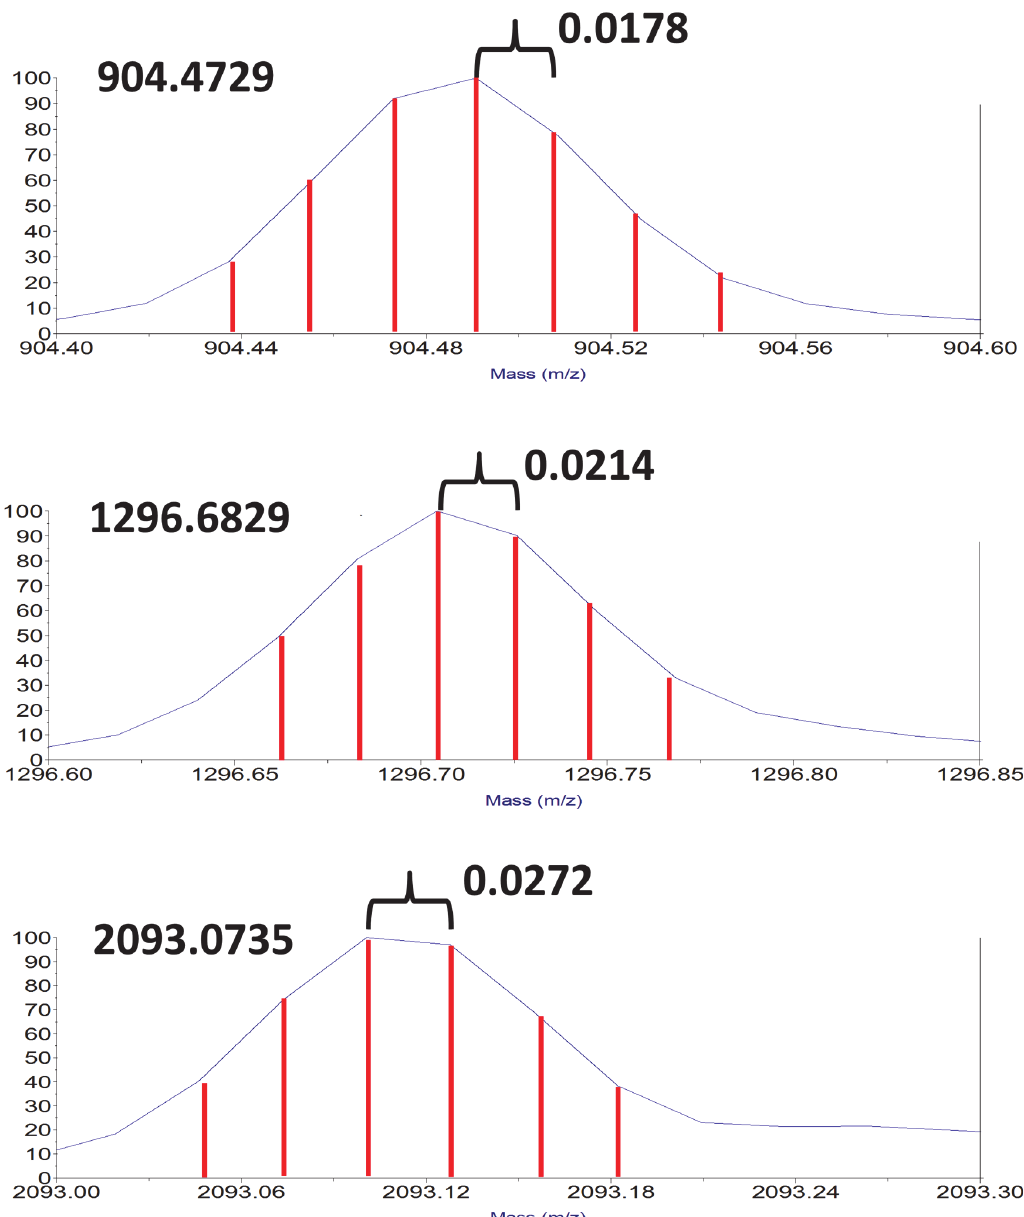
Fig 2. Evidence for discontinuous binning of MALDI-TOF mass spectrometry data for Des-Arg(9) Bradykinin (A), Angiotensin 1 (B), and ACTH 1 – 17 (C). Representative monoisotopic peaks for Des-Arg(9) Bradykinin (MH+ = 904.4676), Angiotensin 1 (MH+ = 1296.6848) and ACTH 1 – 17 (MH+ = 2093.0862) are enlarged to demonstrate the discontinuous sampling points (or bins) within the MALDI-TOF data. The red vertical lines are fitted to the bins evident in the observed peak shapes. The spacing of bins in mass units is larger for higher mass ions and can be accurately calculated by relationship between flight times and the ratio of masses of the molecular ions according to the equation Δ t 2 / Δ t 1 = (M 2 /M 1 ) 1/2 . This calculation is simplistic, but accurately relates the bin spacing for different mass ions to 5 decimal places, thus suggesting that binning of data in the MALDI-TOF instrument is related to the measurements of ion flight